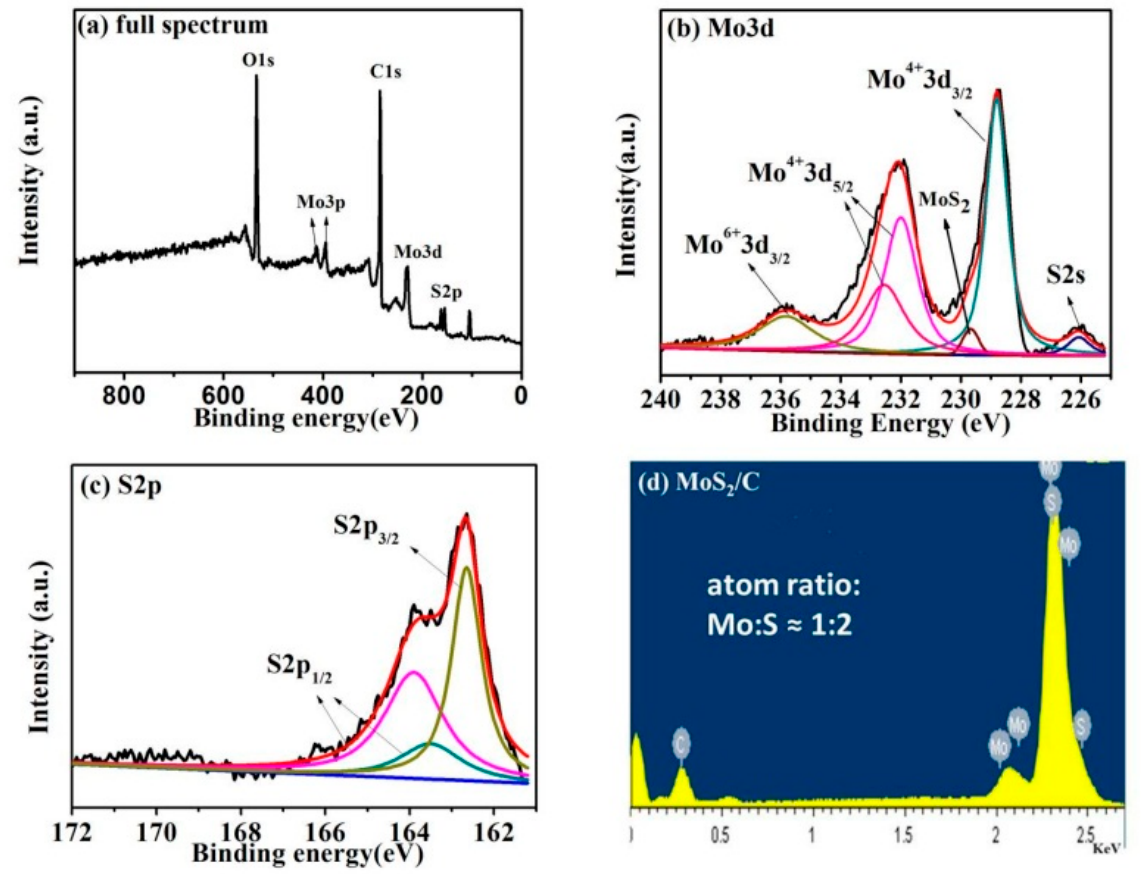
Figure 4. XPS and EDS spectra of the MoS 2 /C composite: ( a ) full spectrum; ( b ) Mo3d spectrum; ( c ) S2p spectrum; ( d ) EDS spectrum.